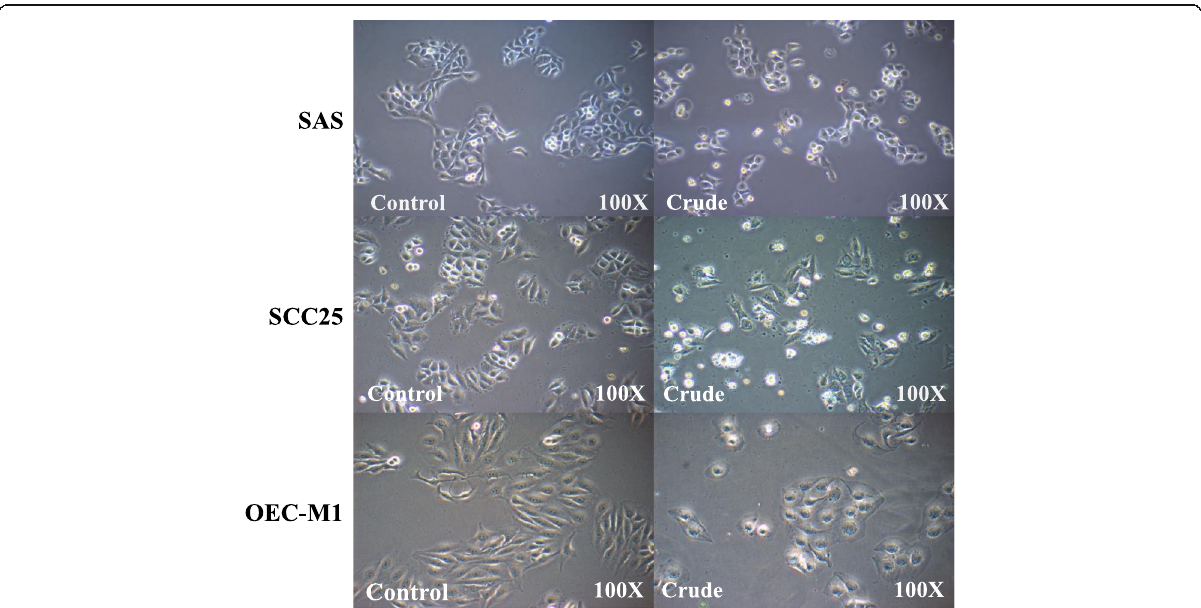
Fig. 1 Danshen crude induced morphological change in oral cancer cells. Effect of the Danshen crude on morphological changes in SAS, SCC25, and OEC-M1 oral cancer cell lines. Original magnification, 100×